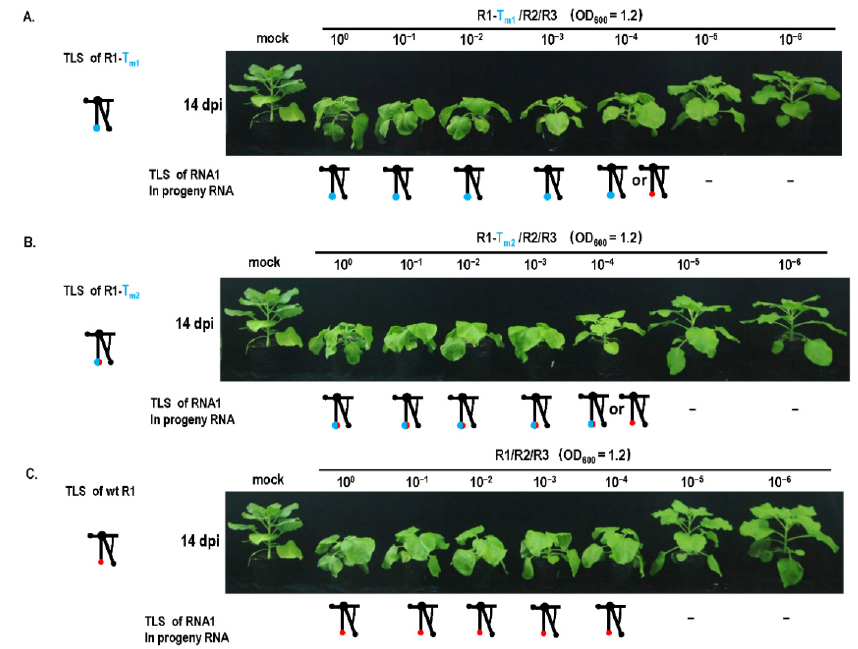
Figure 5. Dilution inoculation of CMV Fny or its variants and mutant repair assay. ( A ) Mutation repair assay under dilution inoculation of R1-T m1 /R2/R3. R1—RNA1 of CMV Fny ; R2—RNA2 of CMV Fny ; R3—RNA3 of CMV Fny ; − —no detectable viral RNA. ( B ) Mutation repair assay under dilution inoculation of R1-T m2 /R2/R3. ( C ) Mutation repair assay under dilution inoculation of CMV Fny .